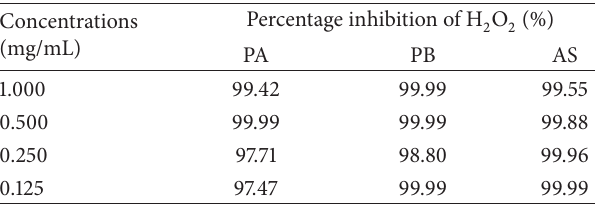
Table 1: Hydrogen peroxide scavenging activity of phenothiazine derivatives.